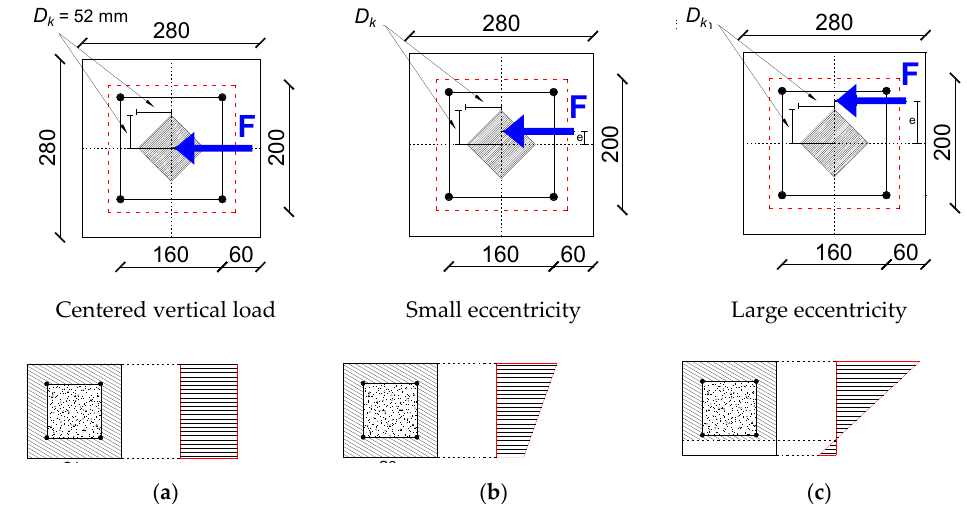
Table 3. Scheme of the specimens and corresponding applied loading conditions.